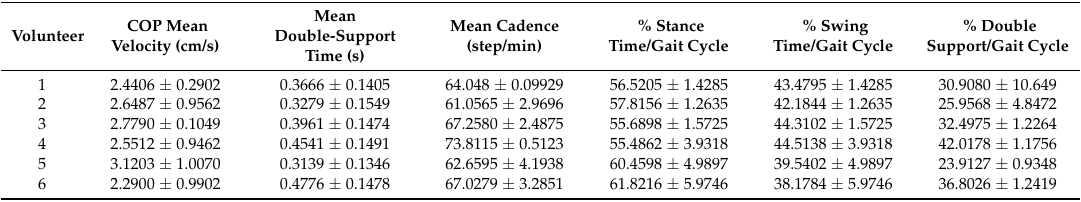
Table 3. Gait segmentation and gait index calculation